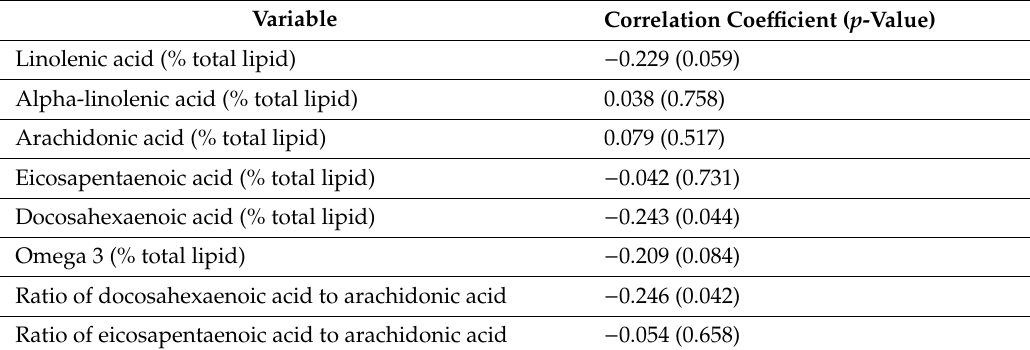
Table 6. Correlation between CIMT and